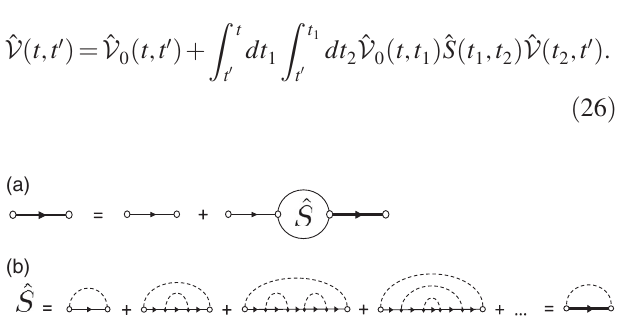
ˆ V ˆ V ( 0 ), ˆ S in the NCA, where only